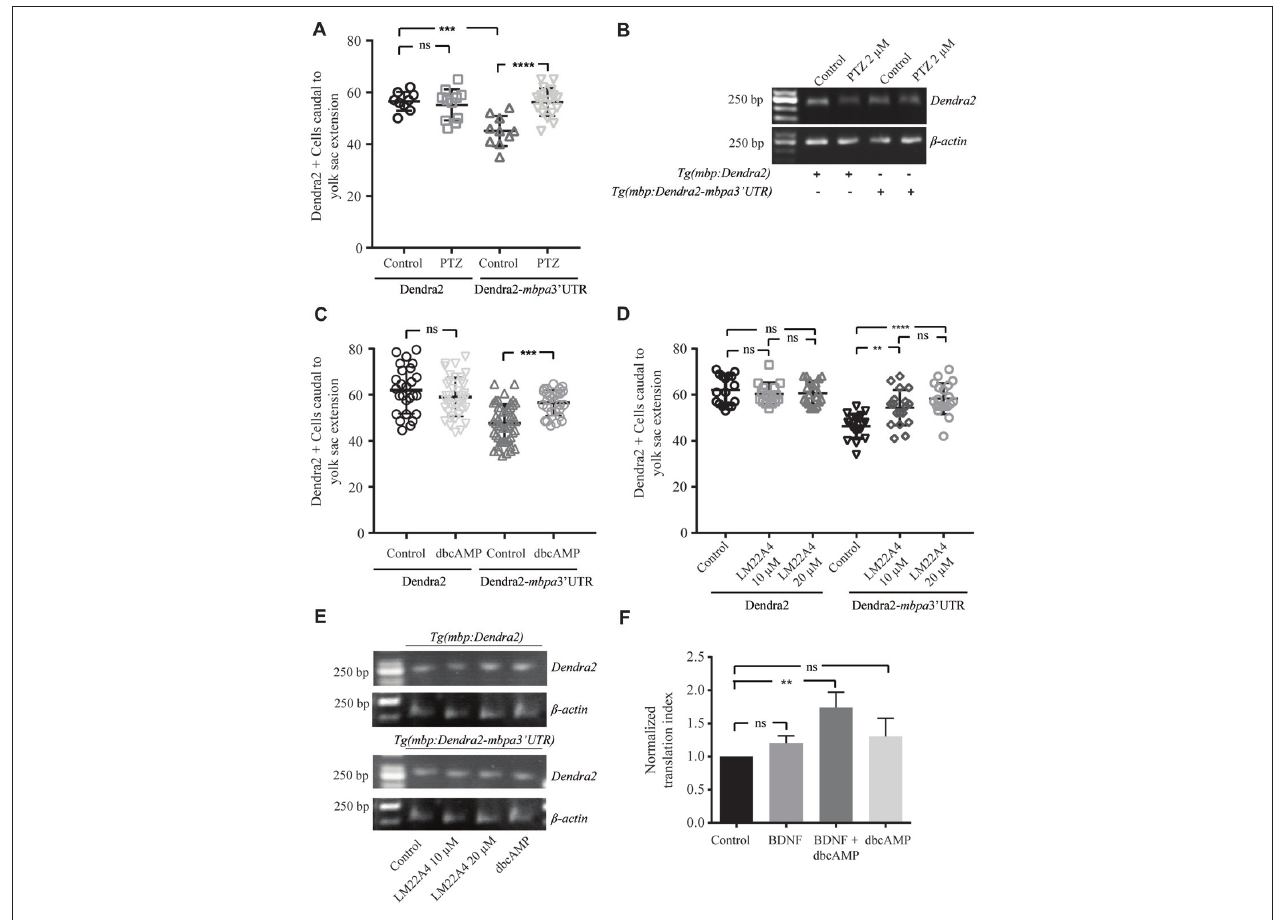
FIGURE 8 | Neuronal activity regulates translation of MBP mRNA in vivo . (A) Tg(mbpa:Dendra2) and Tg(mbpa:Dendra2-mbpa3’UTR) were treated with pentylenetetrazole (PTZ; 2 mM) at 72 hpf. At 96 hpf the number of Dendra2 cells caudal to the yolk sac extension was quantified. Mean ± SD is displayed. ns = not significant, ∗∗∗ p < 0.001, ∗∗∗∗ p < 0.0001. (B) Tg(mbpa:Dendra2) and Tg(mbpa:Dendra2-mbpa3’UTR) were treated with PTZ (2 mM) at 72 hpf. At 96 hpf mRNA was isolated from the larvae and the expression of Dendra2 and actin mRNA was analyzed by RT-PCR. (C) Tg(mbpa:Dendra2) and Tg(mbpa:Dendra2-mbpa3’UTR) were treated with dbcAMP (10 mM) at 72 hpf. At 96 hpf the number of Dendra2 cells caudal to the yolk sac extension was quantified. Mean ± SD is displayed. ns = not significant, ∗∗∗ p < 0.001 (D) Tg(mbpa:Dendra2) and Tg(mbpa:Dendra2-mbpa3’UTR) were treated with 10 or 20 µ M of the TrkB agonist LM22A4 at 72 hpf. At 96